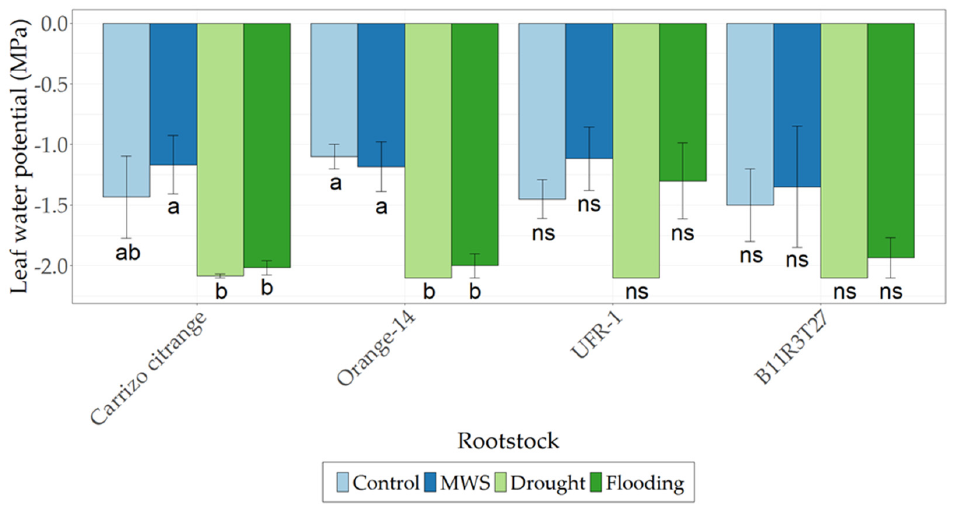
Figure 1. Mean leaf water potential (LWP; MPa) on four citrus rootstocks (Carrizo citrange, Orange-14, UFR-1, and B11R3T27) under four water conditions treatments (Control, MWS, Drought, and Flooding) at the end of the experiment. Values in columns with different letters denote statistical differences among the treatments per citrus rootstock by LSD-Fisher’s test ( p < 0.05). MWS: Mild water stress; ns: not significant differences.